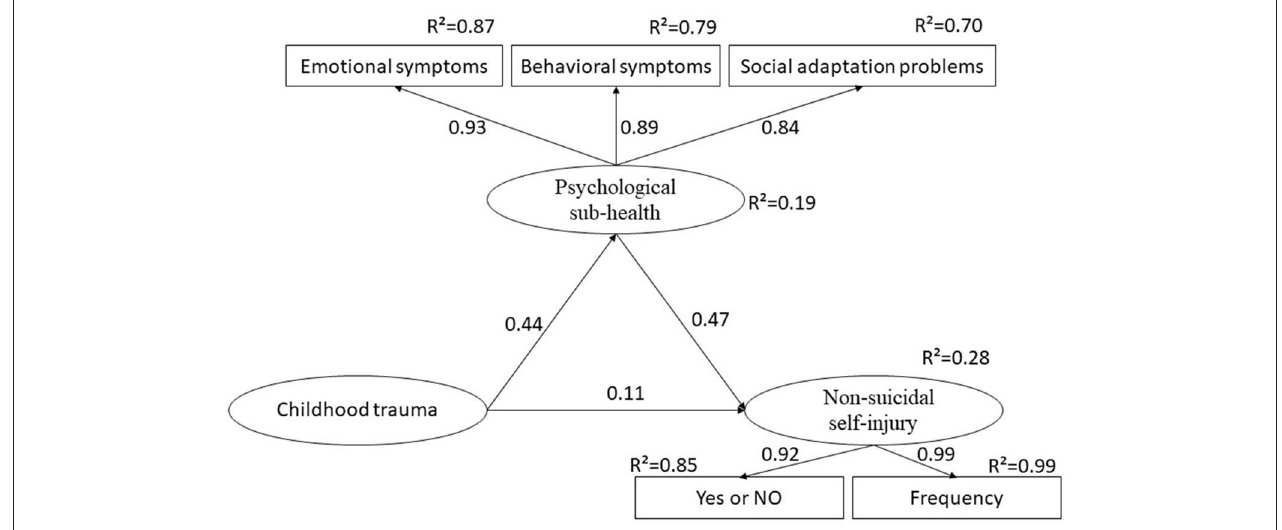
FIGURE 1 | Structural equation model for all the participants. The numbers beside the arrows indicate standardized path coefficients. R ² represents squared multiple correlations. Probability level = 0.512; goodness-of-fit indices: CMIN/DF = 0.892; GFI = 0.997; AGFI = 0.992; NFI = 0.991; RFI = 0.980; IFI = 1.00; TLI = 1.00; CFI = 1.00; RMSEA < 0.001.